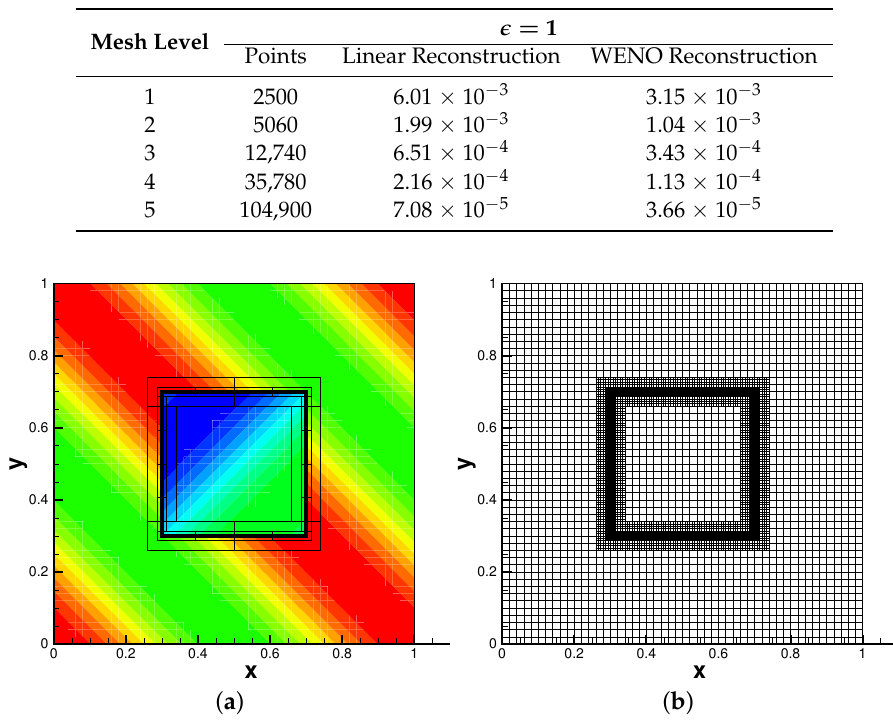
Figure 5. Interpolation of the discontinuous function f 2 using the WENO reconstruction. ( a ) Interpolant function of f 2 with (cid:101) = 1; ( b ) AMR mesh with (cid:101) =